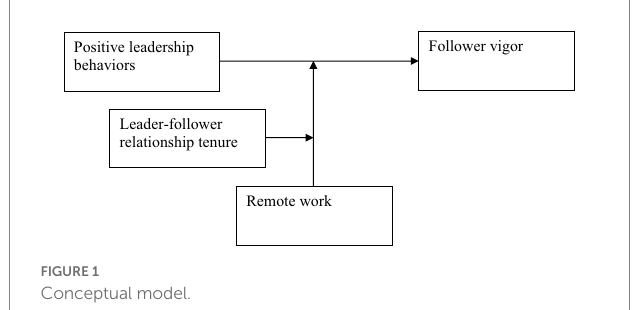
FIGURE 1 Conceptual